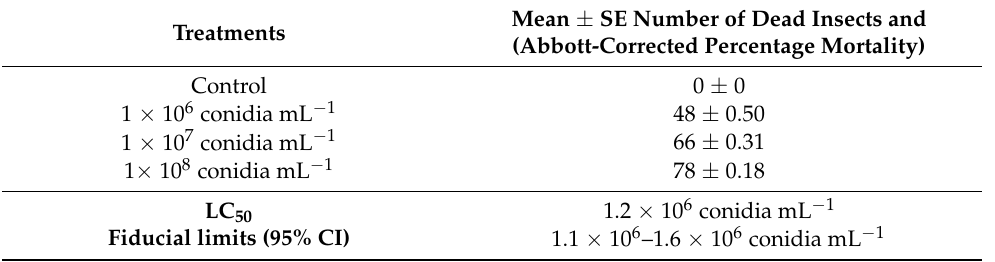
Table 1. The pathogenicity (mean ± SE number of dead insects and (Abbott-corrected percentage mortality), of Beauveria bassiana against Myzus persicae in the laboratory at five days post-treatment. Mean ± SE Number of Dead Insects Treatments